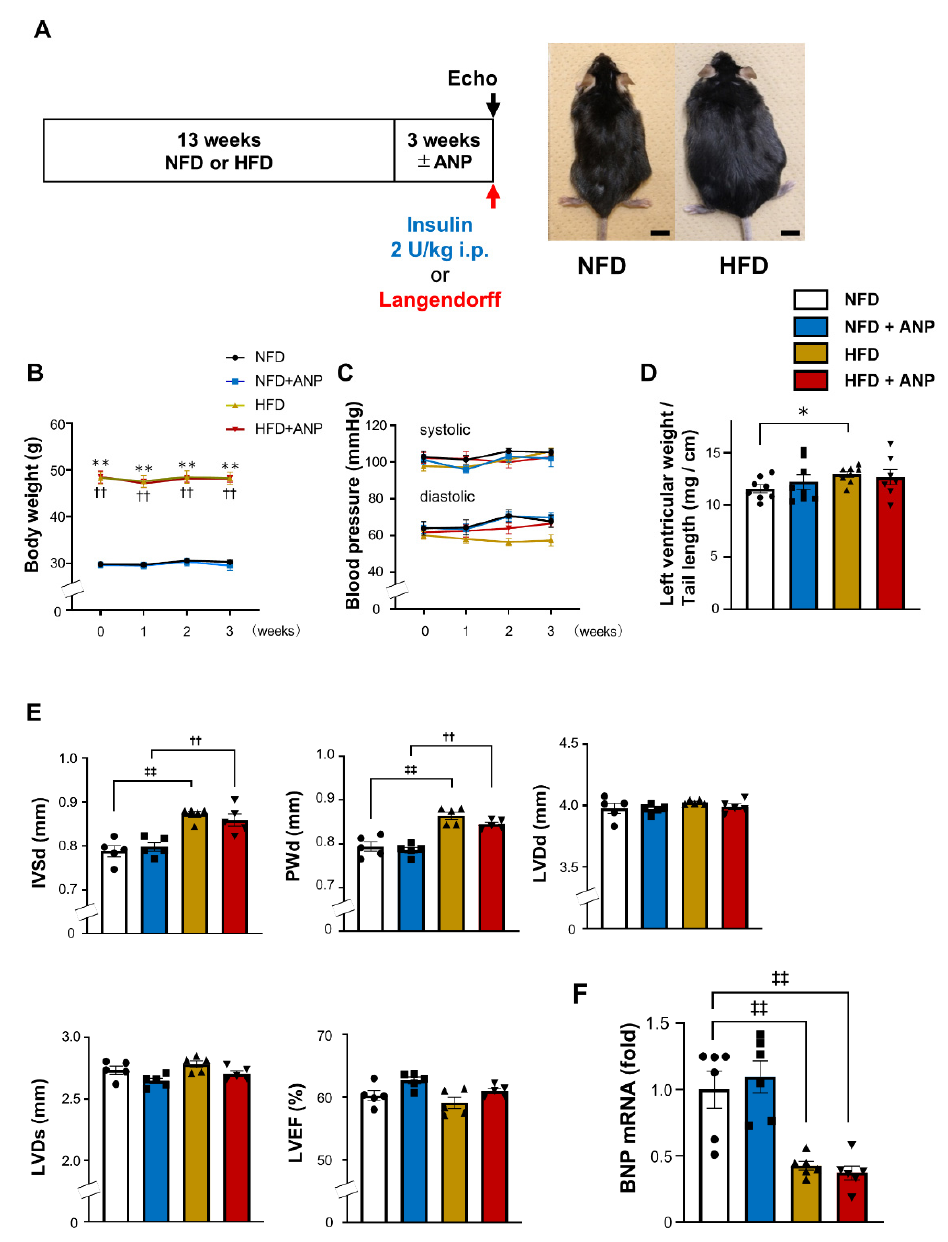
Figure 1. Characteristics of HFD model after treatment with or without ANP. ( A ) A schematic dia- gram of the experimental protocol and appearance of the obese mice after 13 weeks of HFD feeding. Bars = 1 cm. ( B ) Body weight changes during ANP treatment (n = 6 each). ( C ) Blood pressure changes during ANP treatment (n = 4 each). ( D ) Heart weight at three weeks after treatment with or without ANP (n = 8 each, except for HFD+ANP (n = 7)). ( E ) Echocardiographic parameters at three weeks after treatment with or without ANP (n = 5 each). ( F ) The relative mRNA expression of BNP in left ventricle at three weeks after treatment with or without ANP (n = 6 each). The qPCR data were normalized to glyceraldehyde-3-phosphate dehydrogenase (GAPDH). The data are shown as the fold change normalized to the levels found in the NFD group. * p < 0.05 and ** p < 0.01 versus NFD, ‡‡ p < 0.01 versus NFD, †† p < 0.01 versus NFD+ANP. HFD, high-fat diet; IVSd, end-diastolic thick- ness of intraventricular septum; LVDd, left ventricular end-diastolic dimension; LVDs, left ventric- ular end-systolic dimension; LVEF, left ventricular ejection fraction; NFD, normal-fat diet; PWd, end-diastolic thickness of posterior wall. 2.2. ANP Treatment Ameliorated Cardiac Insulin Signaling in HFD Mice